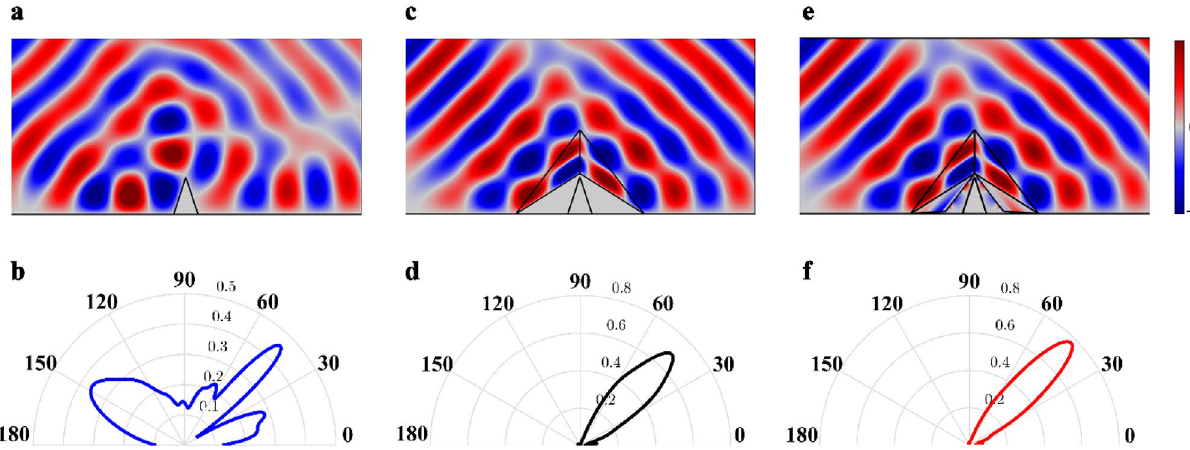
Figure 3. Comparison between the field distribution of target, conventional carpet cloak and the carpet cloak with SSHBs. ( a , b ) The near field distribution and far field scattering pattern of the object with sound hard boundaries. ( c , d ) The near field distribution and far field scattering pattern of conventional carpet cloak. ( e , f ) The near field distribution and far field scattering pattern of the carpet cloak with SSHBs. It can be seen that the results in ( c , d ) and ( e , f ) are closely similar to each